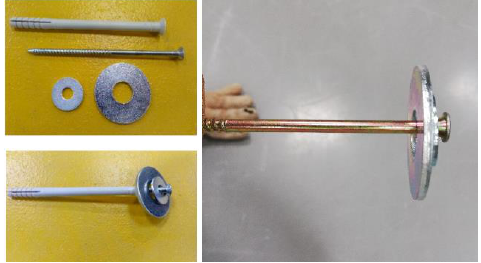
Figure 3. Detail of the steel connectors used to anchor the textile meh.